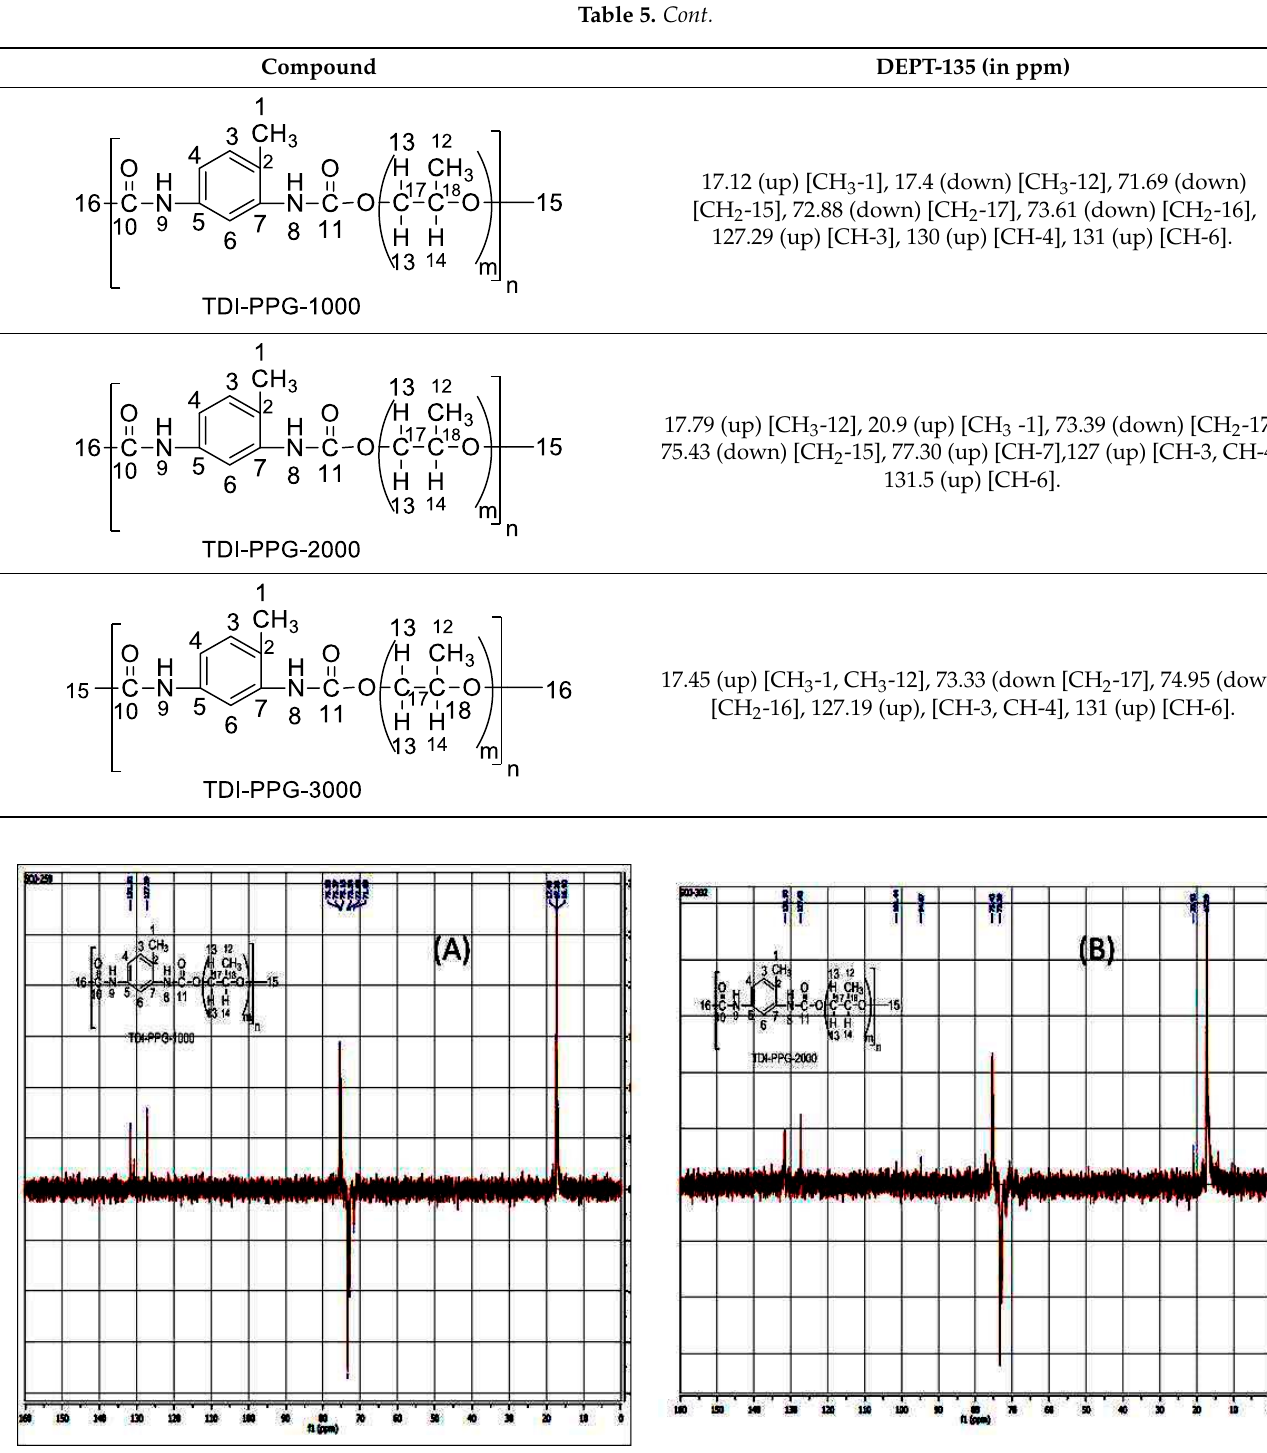
Figure 3. DEPT-135 spectra of ( A ) TDI-PPG-1000 and ( B ) TDI-PPG-2000.